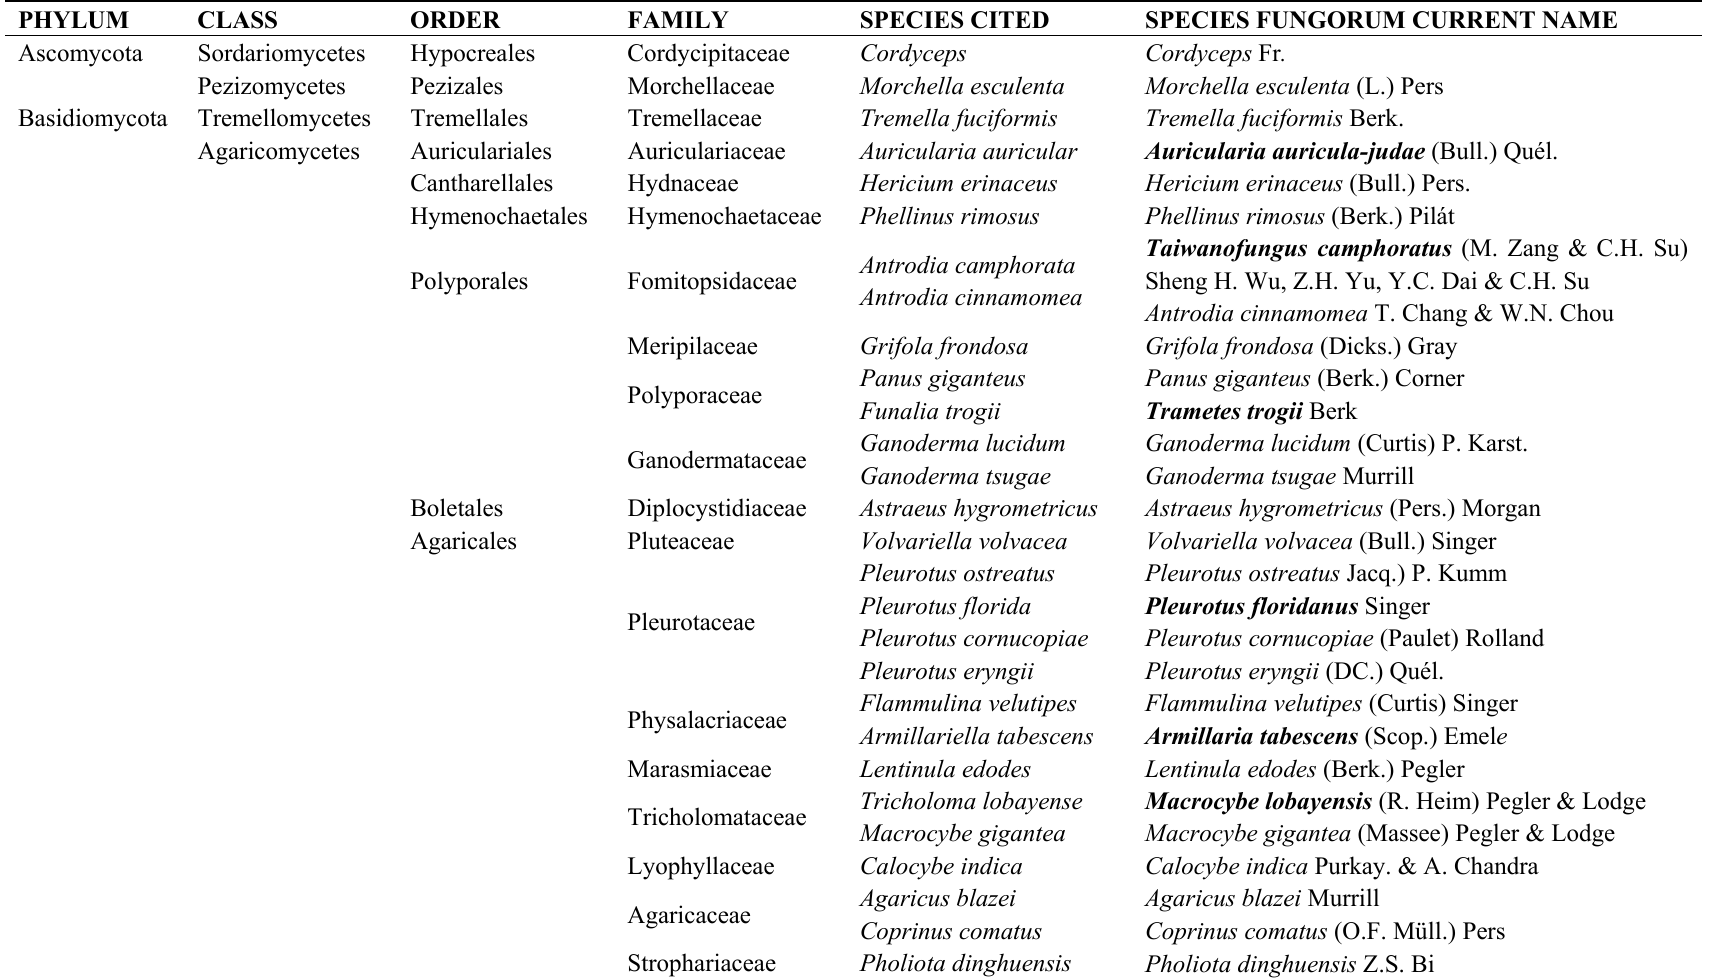
Table 2. Taxonomic position of the species mentioned and species fungorum current names